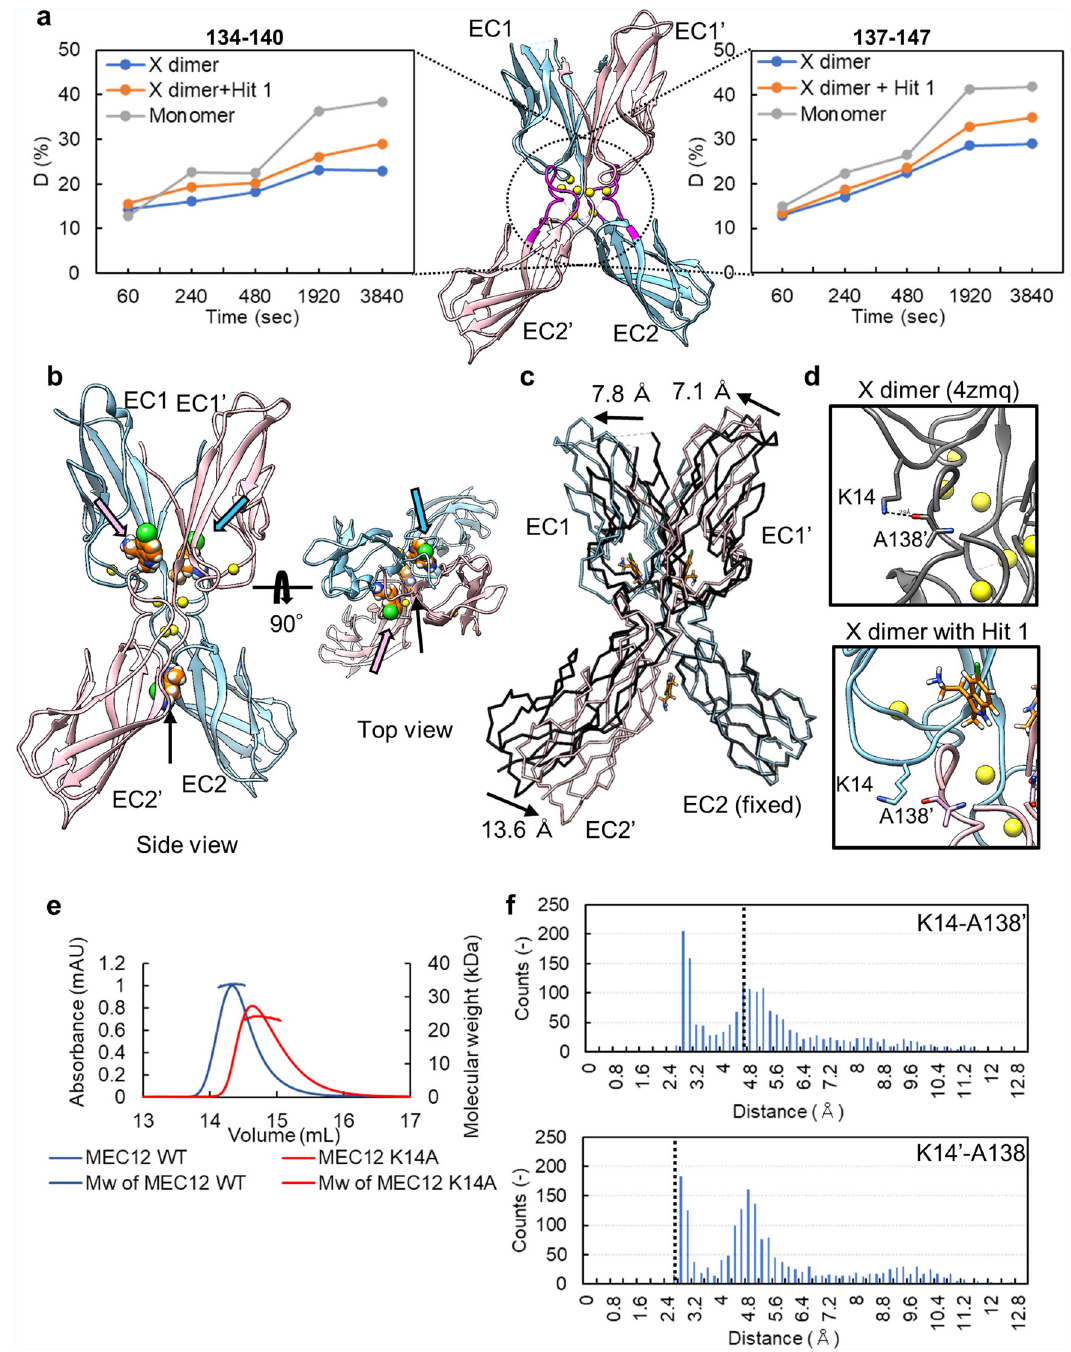
Fig. 3 Effects on X dimerization by Hit 1. a Hydrogen – deuterium exchange ratio of two peptides 134 – 140 and 137 – 147 as a function of time. The region of these peptides is colored in magenta in the structure of MEC12, X dimer (PDB ID; 4zmq). Chain A of X dimer is colored in sky blue; chain B in pink. b Structure of the complex of the X dimer and Hit 1. Hit 1 (in the sphere, orange) is bound in the cavity around Y140 of each monomeric chain and at the intersection of EC2 domains. The pink or sky blue or black arrows show Hit 1 that binds to chain A or chain B or at the intersection of EC2 domains, respectively. c Structural change caused by the binding of Hit 1. Hit 1-bound X dimer is aligned to the apo-state X dimer (PDB ID; 4zmq, black). The angle of EC1 to EC2 is fl atter compared to that in the apo-state X dimer. The arrows indicate the movement of domains. d Hydrogen bonds disrupted by the structural change that occurs upon Hit 1 binding. In the apo-state X dimer, K14-A138 ’ hydrogen bond is shown in the dotted line. In Hit 1-bound X dimer, the K14-A138 ’ hydrogen bond is disrupted. Amino acid residues from chain A are shown in sky blue, those from chain B are in pink. e Size measurement using SEC-MALS. The WT X dimer trace is in blue, the K14A mutant trace is in red. N = 1. f Frequency histogram of the distance between a hydrogen bond donor and an acceptor of the pairs of K14-A138 ’ and K14 ’ -A138 observed in the MD simulations of the apo-state X dimer (PDB ID; 4zmq). The black dotted lines represent the distances observed in the crystal structure of Hit 1-bound X dimer we obtained in this study.